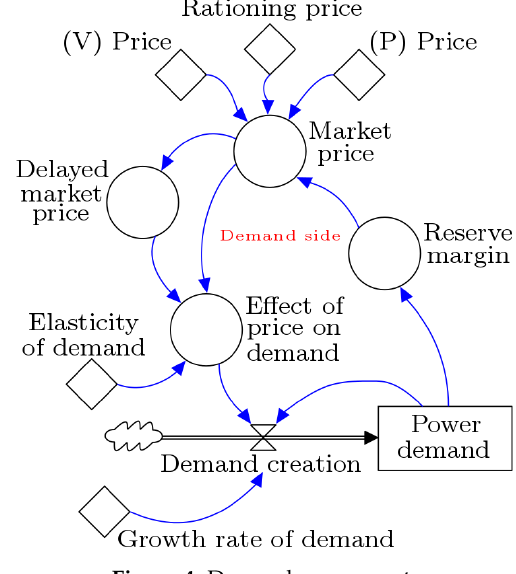
Figure 4. Demand component.